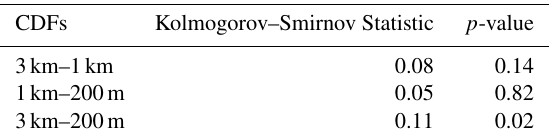
Table 2. The Kolmogorov–Smirnov statistic results and the corre- sponding p -value. The results are based on the difference between the KGE distributions of the three model instances: 3km, 1km, and